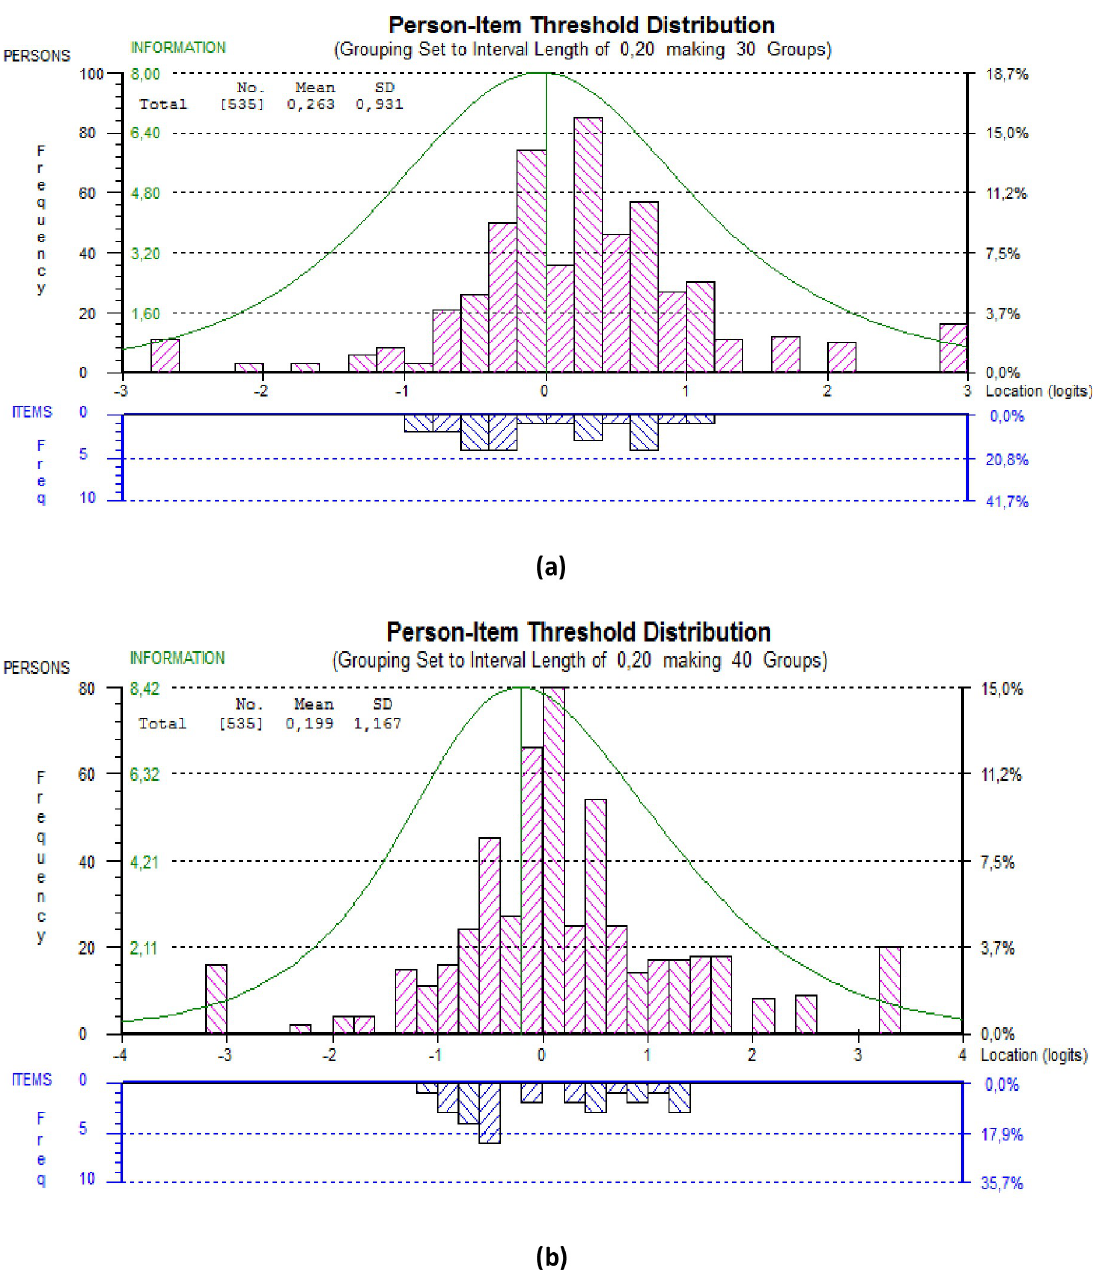
Fig 1. Person estimates and item estimates for the Short-PEC. a. Person estimates and item estimates for the Short-PEC intrapersonal component (6 items). b. Person estimates and item estimates for the Short-PEC interpersonal component (7 items). Person abilities represent the person level on the scale. The higher the person ability is, the higher the person’s score on the intrapersonal or interpersonal component of the Short-PEC. The parameters represented for items are difficulty parameters. Almost all the item difficulty parameters are between -1 and 1. The curve represents the total information curve. The scale is adapted to the population if the item distribution covers the whole range of person abilities.